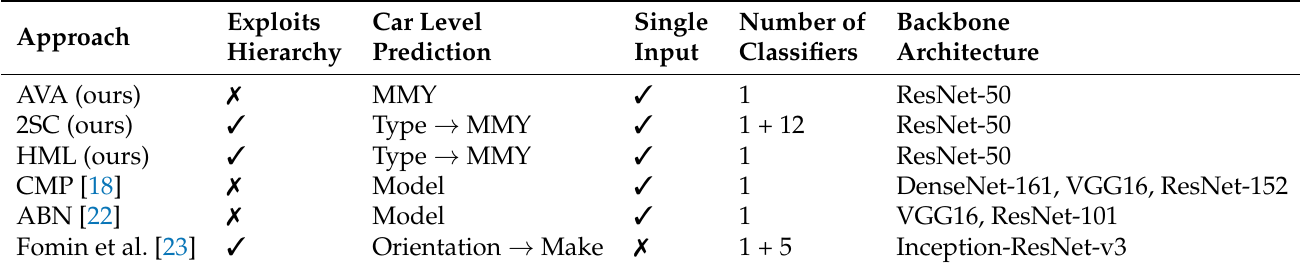
Table 2. Characteristics comparison between different approaches for car classification. The first group is described in Section 4: All-vs.-all (AVA), Two-step cascade (2SC), and Hierarchical multilabel (HML). The second group is described in Section 2: Channel Max Pooling (CMP), Attention Branch Network (ABN), and the method by Fomin et